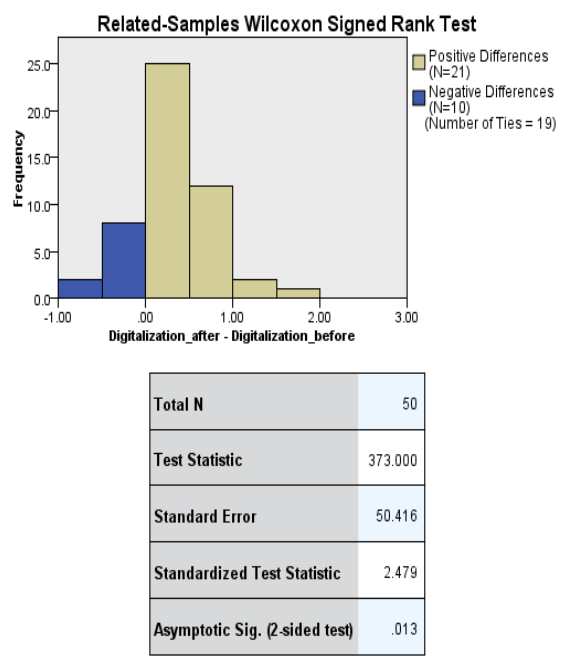
Figure 2. Results of the related-samples Wilcoxon Signed Rank